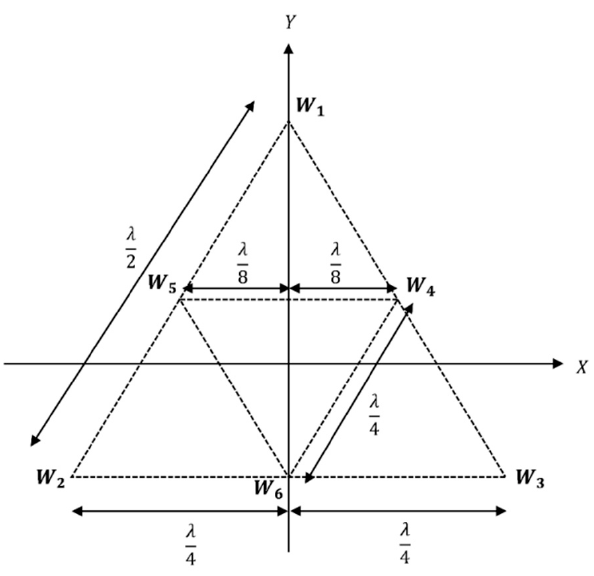
Figure 2. Schematic Diagram of the Proposed Two-Triangular Configuration.